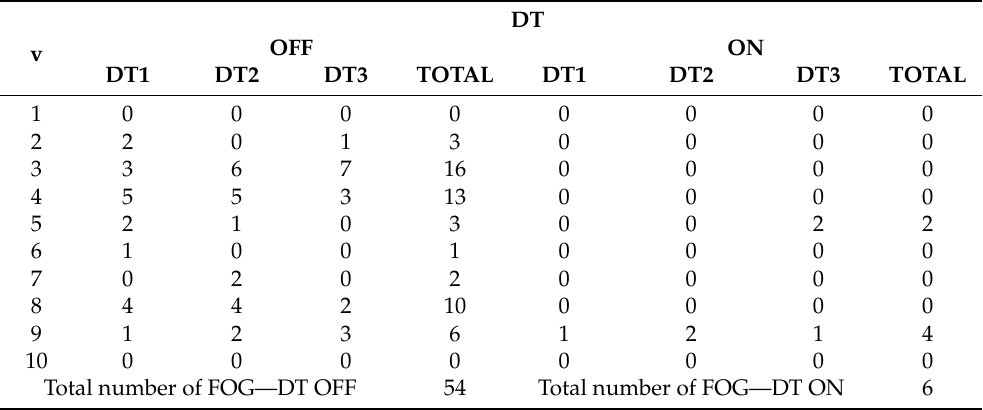
Table 5. Number of FOG episodes for each volunteer and the total number of FOG episodes during the OFF- and ON-medication states for the dual task